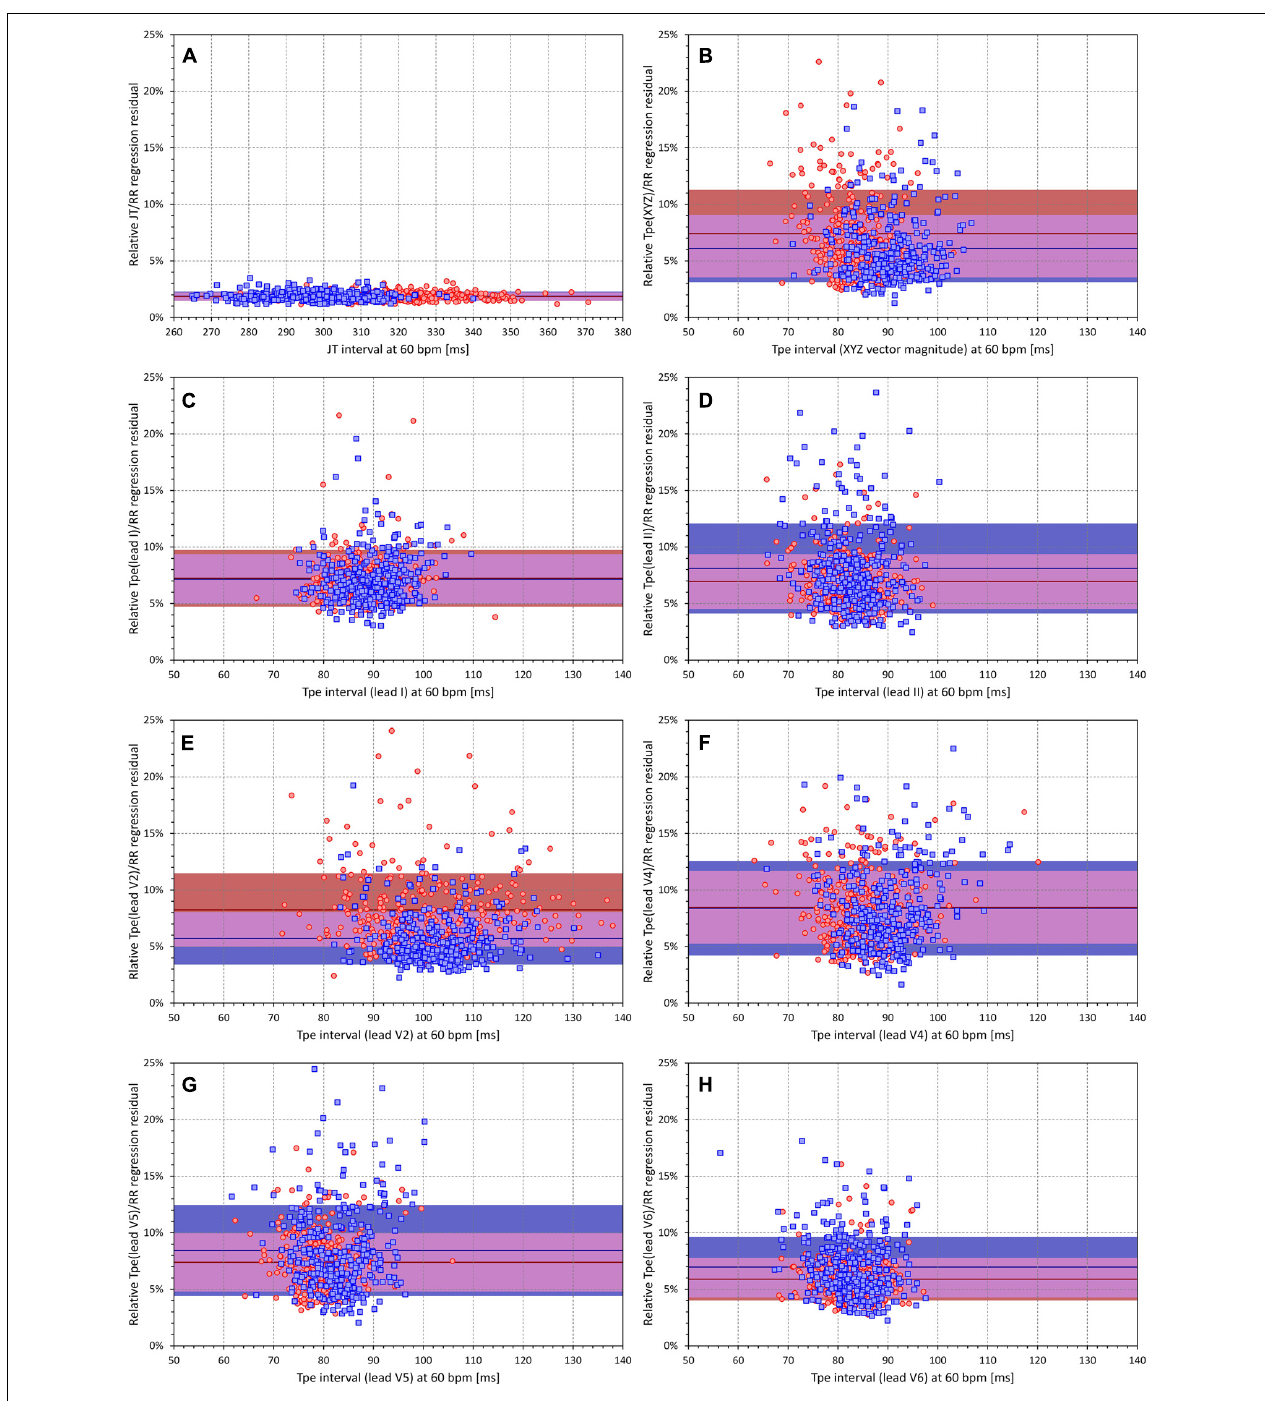
FIGURE 8 | (A) Scatter diagram between JT intervals at heart rate of 60 bpm and relative linear JT/RR regression residuals (see the text for explanation). (B–H) Similar scatter diagrams between Tpe intervals at heart rate of 60 bpm and relative linear Tpe/RR regression residuals; the panels correspond to the Tpe measurement in different electrocardiogram (ECG) leads in the same way as the panels of Figure 5 . In each panel, the red circles and blue squares correspond to female and male subjects, respectively. The solid red and solid blue horizontal lines show the means of the relative regression residuals in female and male subjects, respectively. The red- and blue-shaded areas are the bands of mean ± standard deviation of the relative regression residuals in female and male subjects, respectively. The violet areas are the overlaps between the ± standard deviation bands of both sexes.